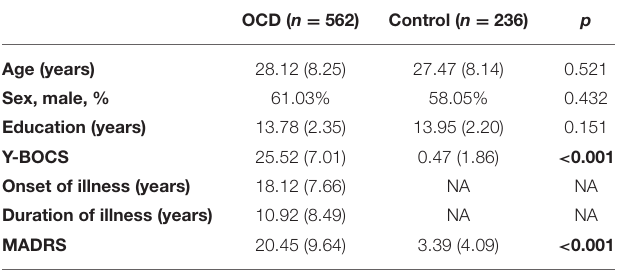
TABLE 1 | Demographic and clinical characteristics of